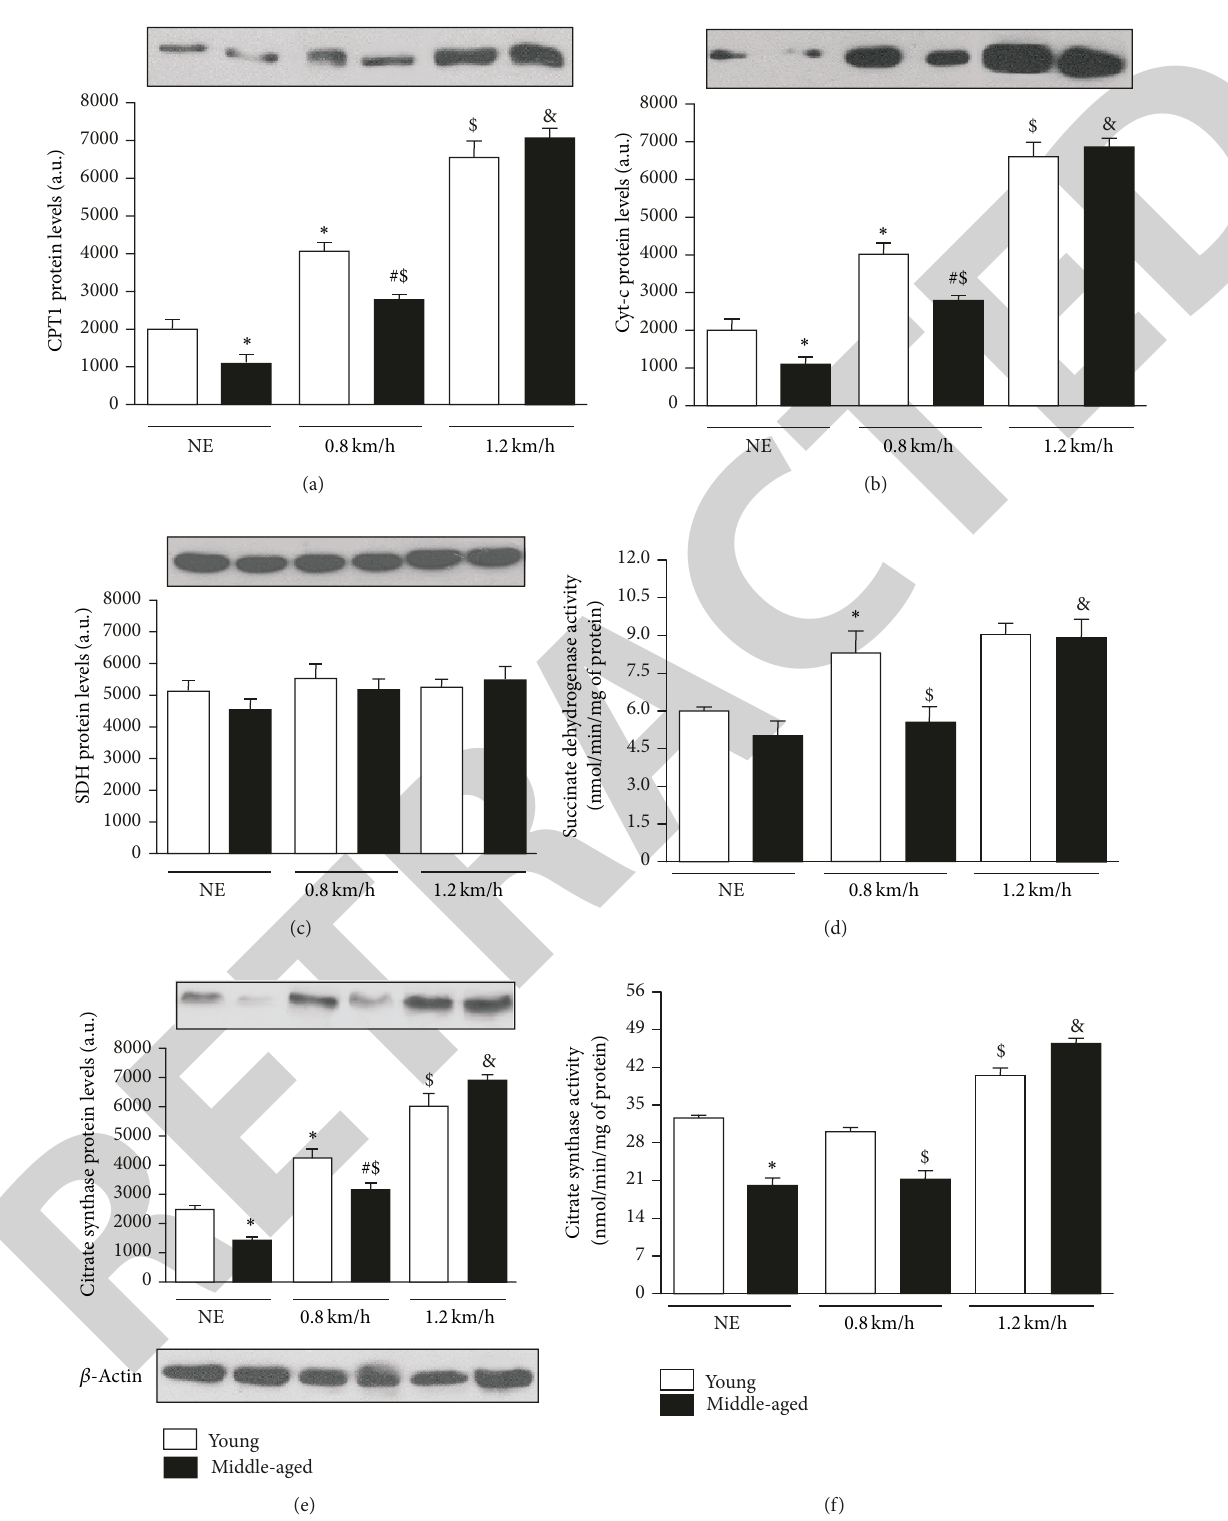
Figure 3: Effects of exercise protocols performed in different intensities on the CPT1, Cyt-c, citrate synthase, and SDH protein levels and SDH and citrate synthase activity in the quadriceps of young and middle-aged rats. Protein levels of CPT1 (a), Cyt-c (b), SDH (c), and citrate synthase (e). Upper panels show representative blots of these proteins. The results of scanning densitometry are expressed as arbitrary units. The activities of succinate dehydrogenase (d) and citrate synthase (f) are expressed as nmol/min/mg of protein. Bars represent means ± SEM of six rats. ∗ 𝑃 < 0.05 versus young NE rats, # 𝑃 < 0.05 versus middle-aged NE rats, $ 𝑃 < 0.05 versus young rats at 0.8 km/h, and & 𝑃 < 0.05 versus middle-aged rats at 0.8 km /